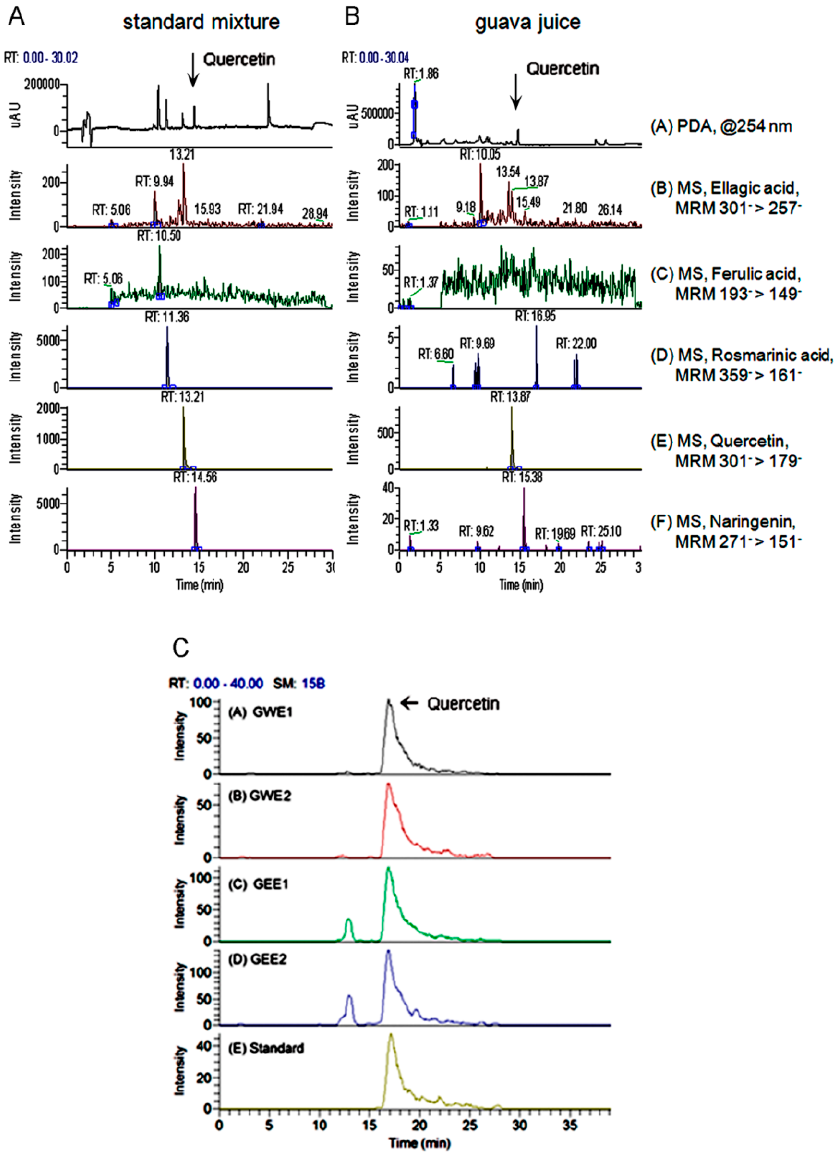
Figure 1. Typical chromatogram of quercetin content in the extract of guava by HPLC analysis. ( A ) The chromatogram of the standard mixture is shown in the left panel ( A ), whereas the chromatogram of the water guava extract is indicated in the right panel ( B ); Five chemicals including ellagic acid, ferulic acid, rosmarinic acid, quercetin and narinegenin are identified in the standard mixture. Only quercetin is found in the guava juice; ( C ) Quercetin content in the extract of guava juice by HPLC analysis.